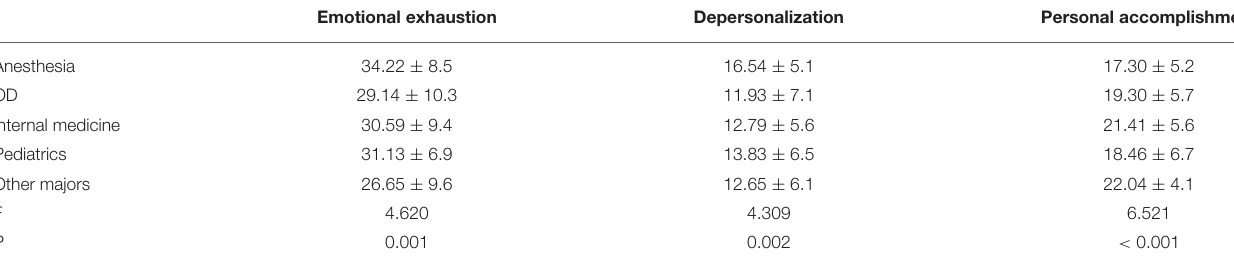
TABLE 2 | The comparison of MBI among different majors.